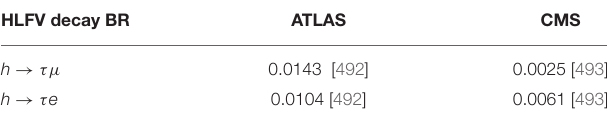
TABLE 4 | Experimental 95 % C.L. upper bounds on HLFV decays from ATLAS and CMS in the tau sector using the 13 TeV data